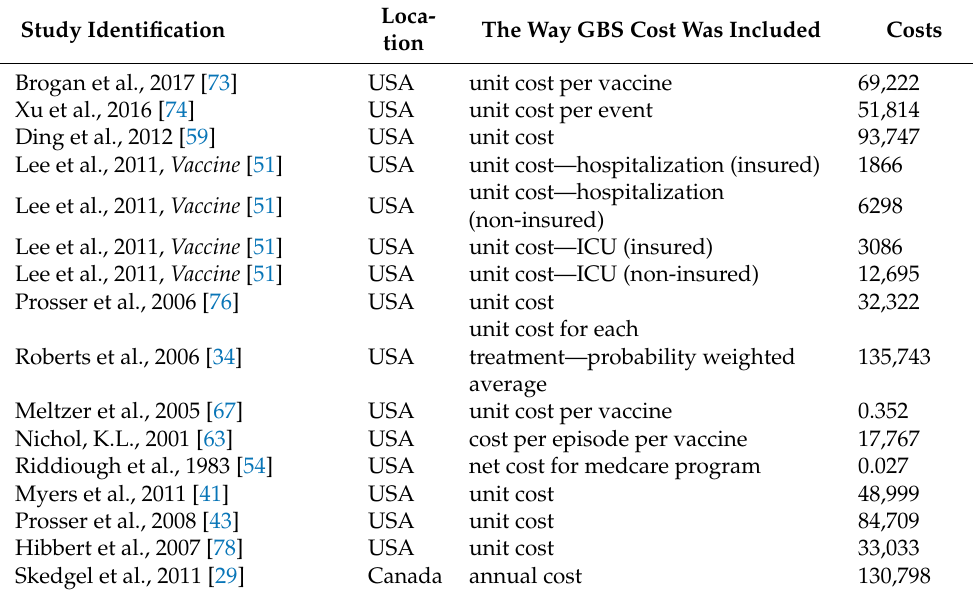
Table 4. Guillain–Barr é syndrome—related